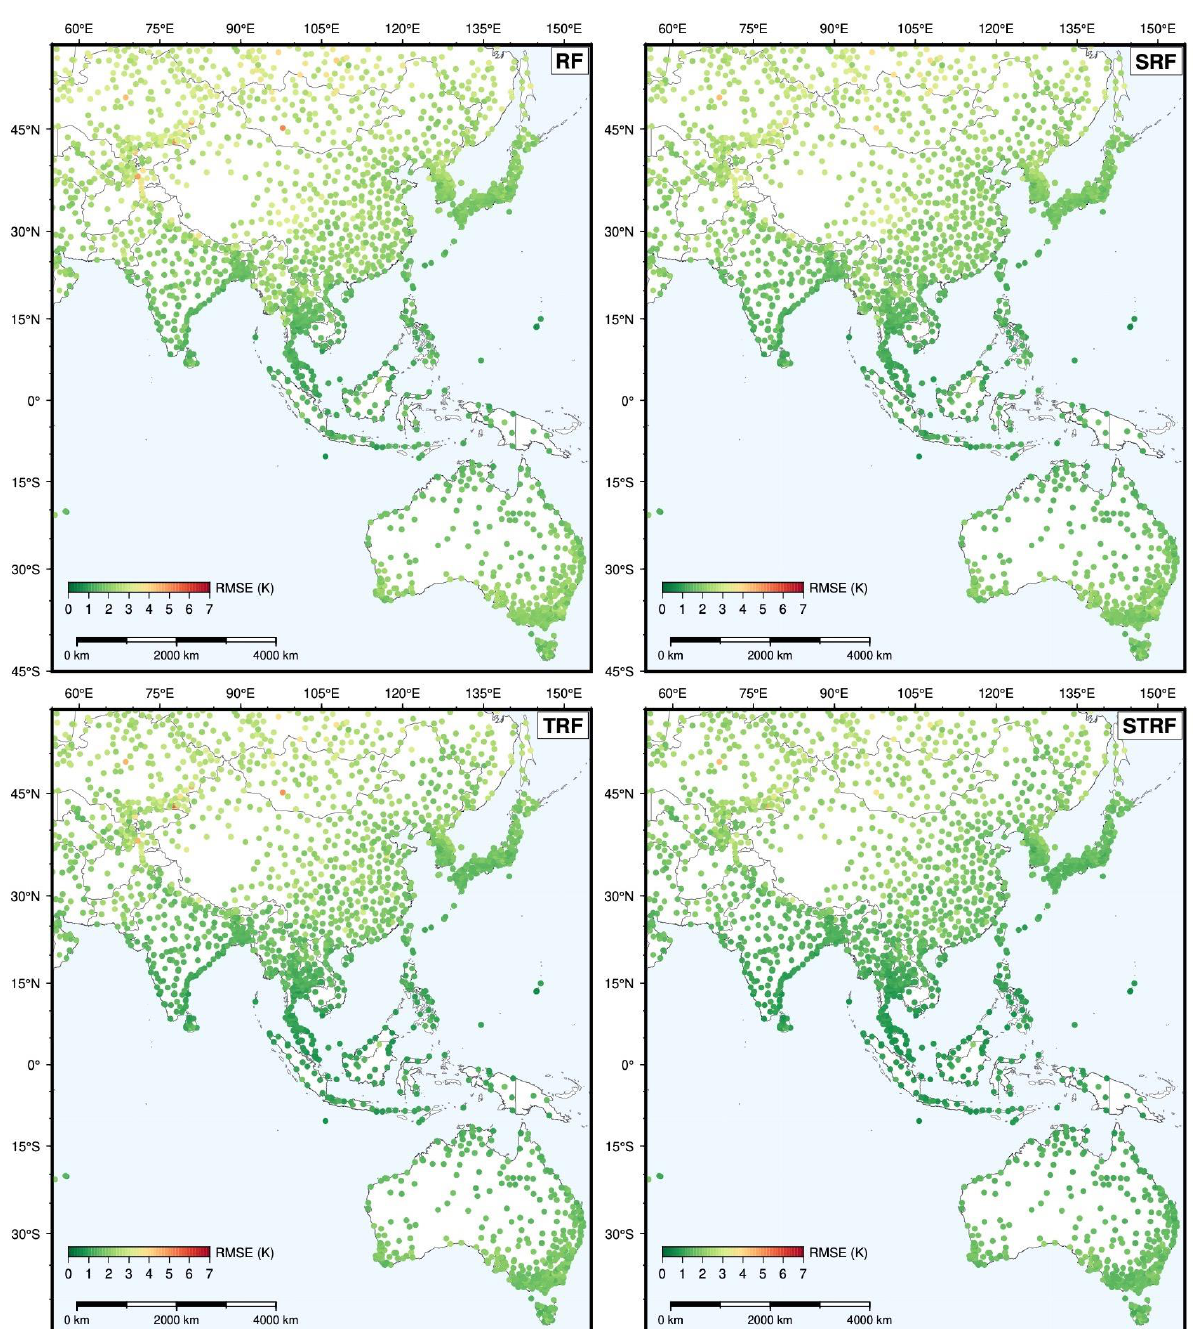
Figure 6. Spatial distribution of site-specific mean RMSE across the study area for the four hourly estimation models using sample-based cross-validation.